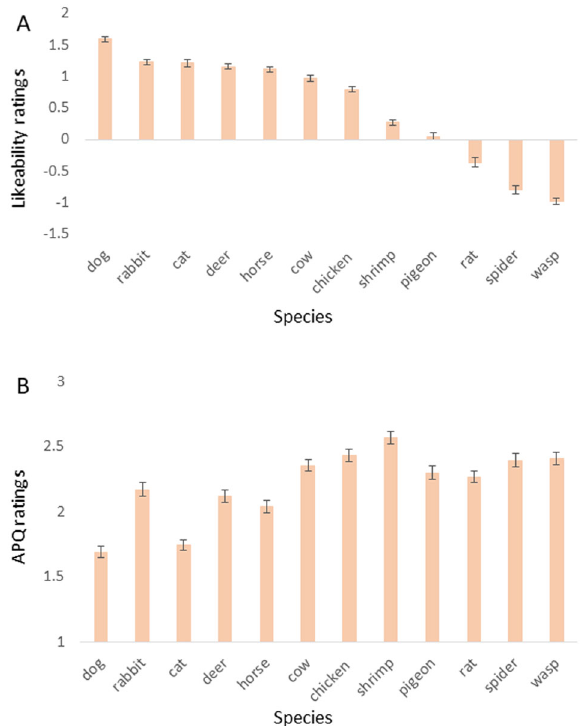
Fig. 1 Average ratings by species. Error bars show two standard errors of the mean. A Likeability ratings for each species, where 2 indicates a strong liking for the species, − 2 indicates a strong disliking and 0 suggests participants are neutral/uncertain of their feelings. B APQ scores where 3 indicates a neutral attitude and scores below 3 re fl ect varying levels of disagreement with the use of the listed animal